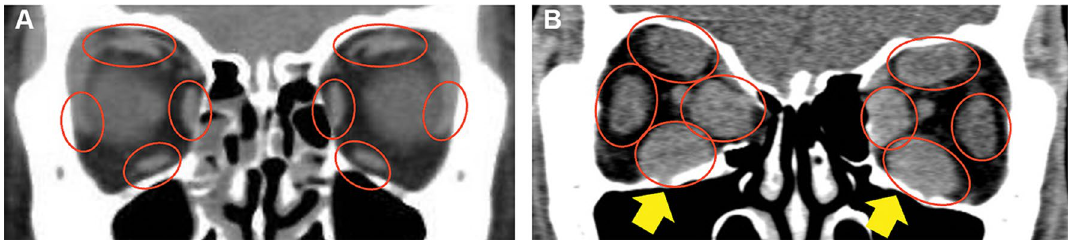
Figure 1. Representative images of extraocular muscles in normal ( A ) and TED ( B ). Red hollow circles indicate extraocular muscles in the human orbit. ( A ) Normal extraocular muscles shown in the coronal view in orbit CT are relatively flat. ( B ) Extraocular muscles in TED are thick and clubby compared with normal extraocular muscles, which are called extraocular muscle enlargements . In general, extraocular muscle enlargements in TED start at the inferior rectus muscles (yellow